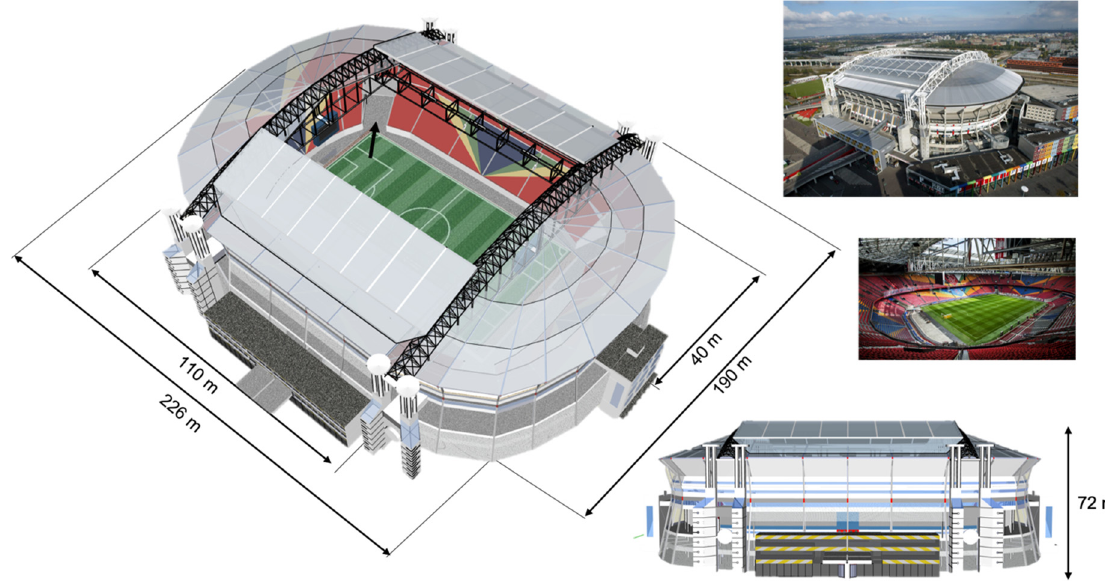
Figure 1. ( a ) Semi-enclosed stadium with neighboring buildings within 300 m from the stadium. ( b ) Three-dimensional CAD geometry model of the stadium. ( c ) Vertical cross-section view of the computational domain. ( d ) Horizontal cross- section view of the computational domain.